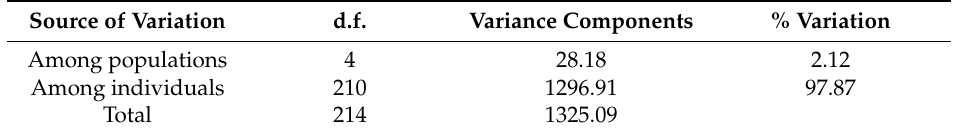
Table 4. Pairwise Genetic distances (FST) between sampling locations (the number of samples is provided in brackets), d.f. = degrees of